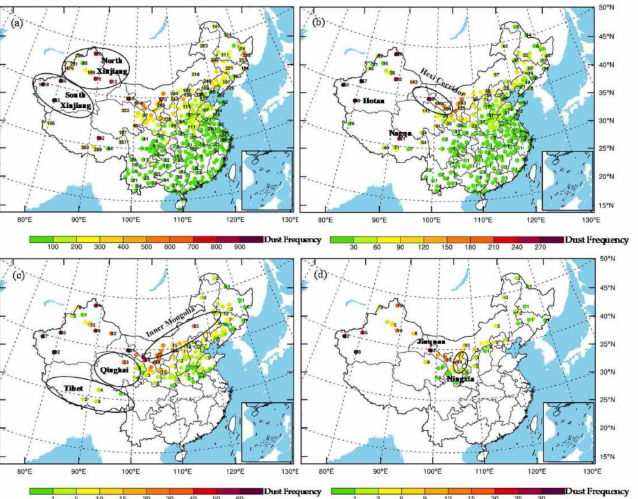
Figure 1. Spatial distribution of dust event frequencies of 336 cities in China from 2015 to 2020: ( a ) dust level I; ( b ) dust level II; ( c ) dust level III; ( d ) dust level